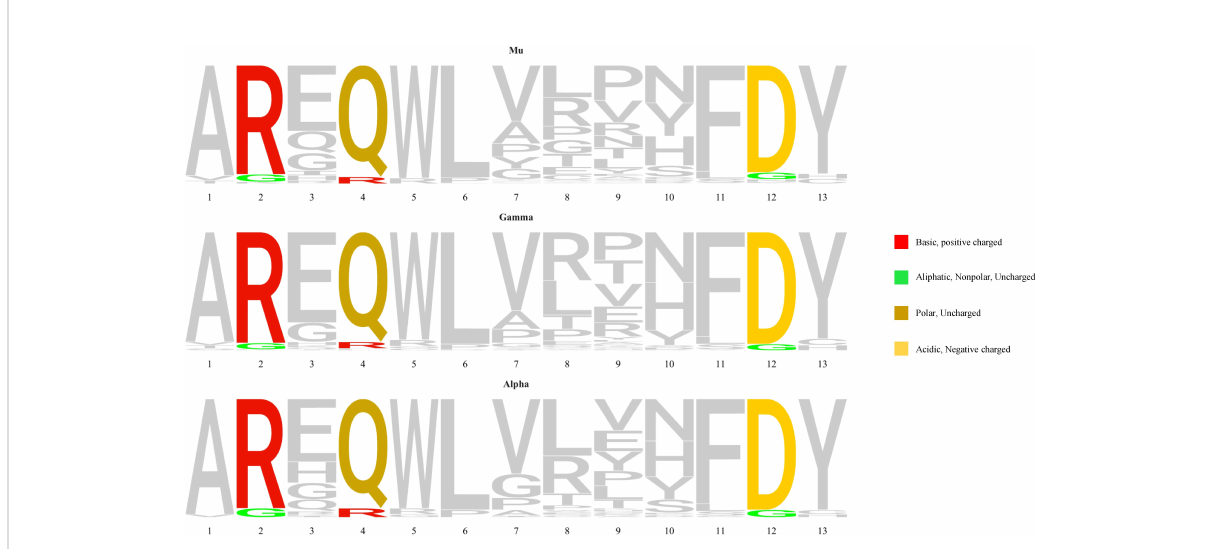
FIGURE 2 VH CDR3 amino acid sequence logos for subset #1 patients showing in color the positions with the most frequent substitutions in the VH CDR3 of the dominant mu and the switched gamma or alpha variants, as well as the most frequent substitutions at these positions. Each amino acid is colored according to its physicochemical properties, using the IMGT coloring system (https://www.imgt.org/IMGTeducation/), namely the basic (red) arginine as well as the acidic (yellow) aspartic residues mutate to the nonpolar (green) uncharged glycine residue, whereas the uncharged and polar (dark yellow) glutamine is replaced by a basic arginine residue